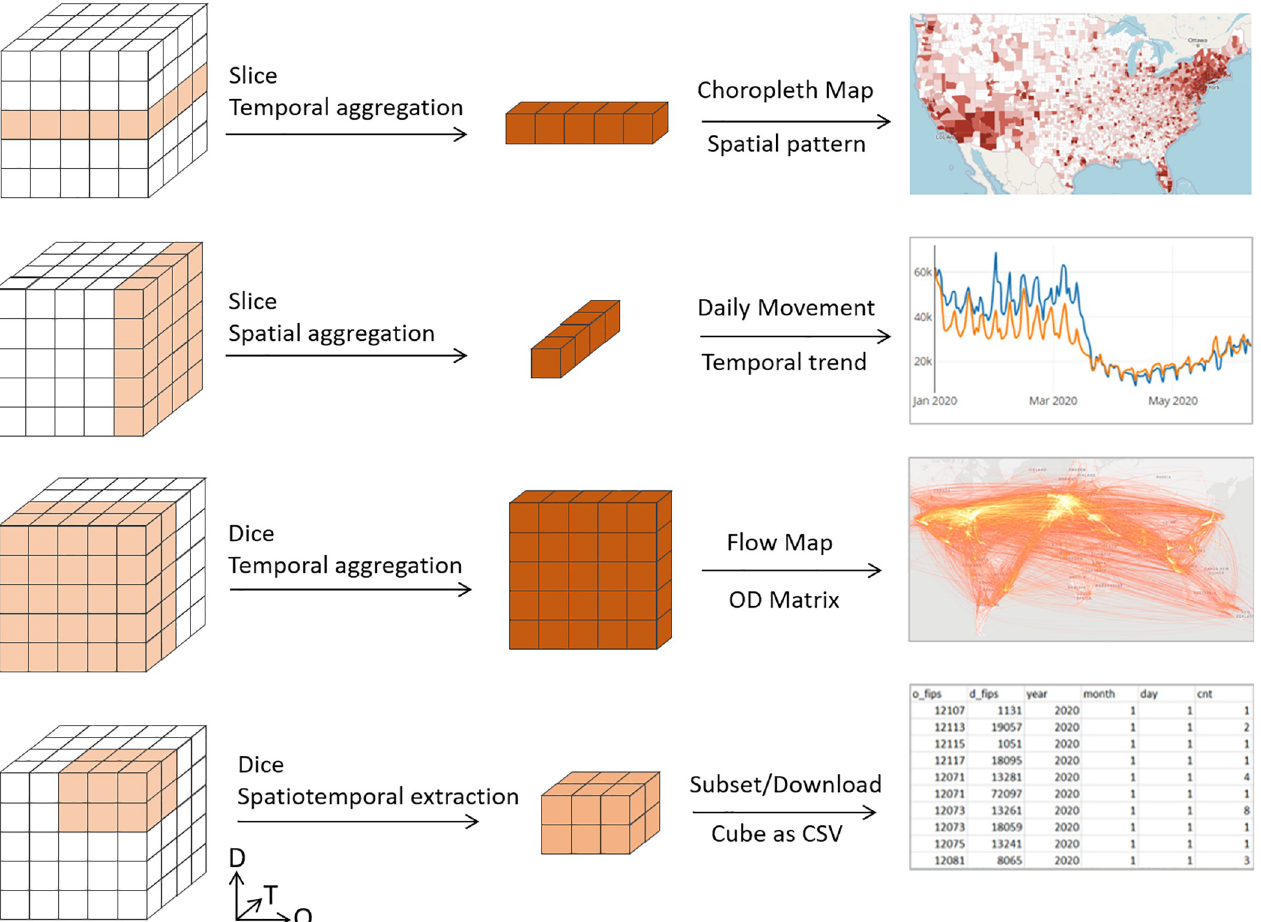
Fig 3. Four application scenarios exemplifying how ODT cube coupled with the traditional cube operations and a scalable parallel computing environment can help analyze big mobility data.